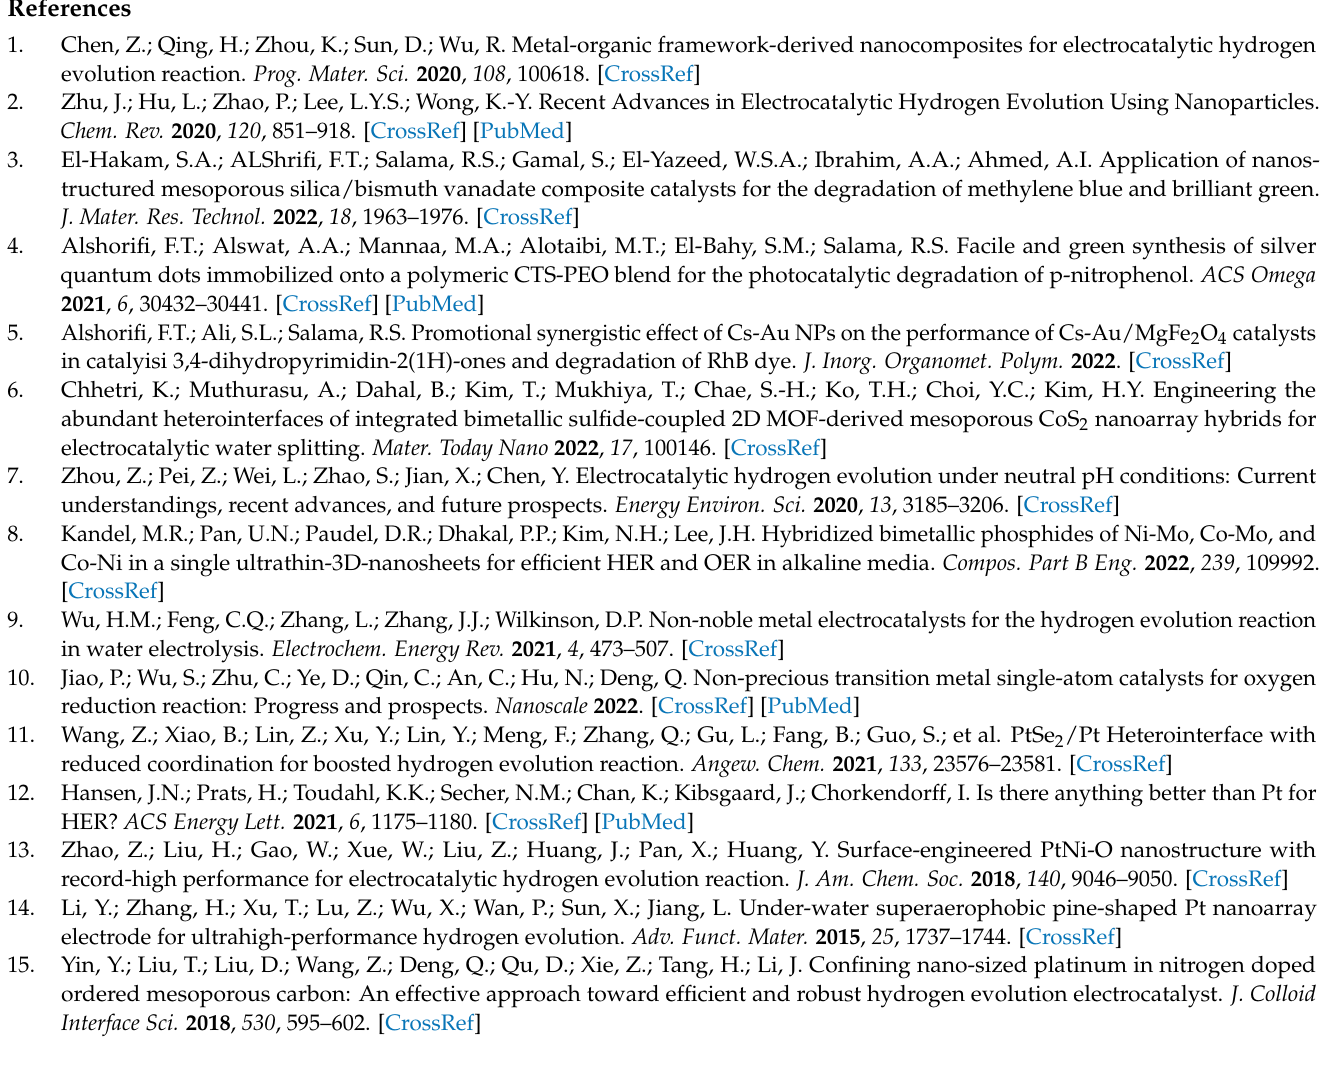
composites; Figure S8: SEM image of Ni 5 P 4 -Se catalyst after long cycles; Table S1: Comparison of the catalytic activity of catalysts